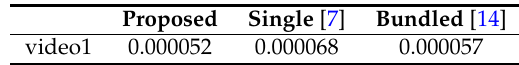
Table 3. Perspective distortion of the various video stabilization methods.